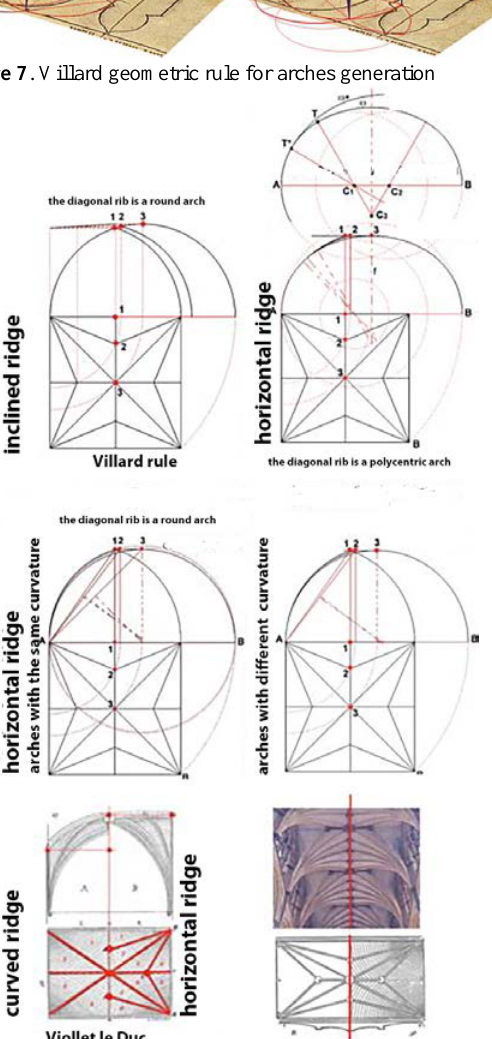
Figure 6. Cavallari-Murat, star vaults classification